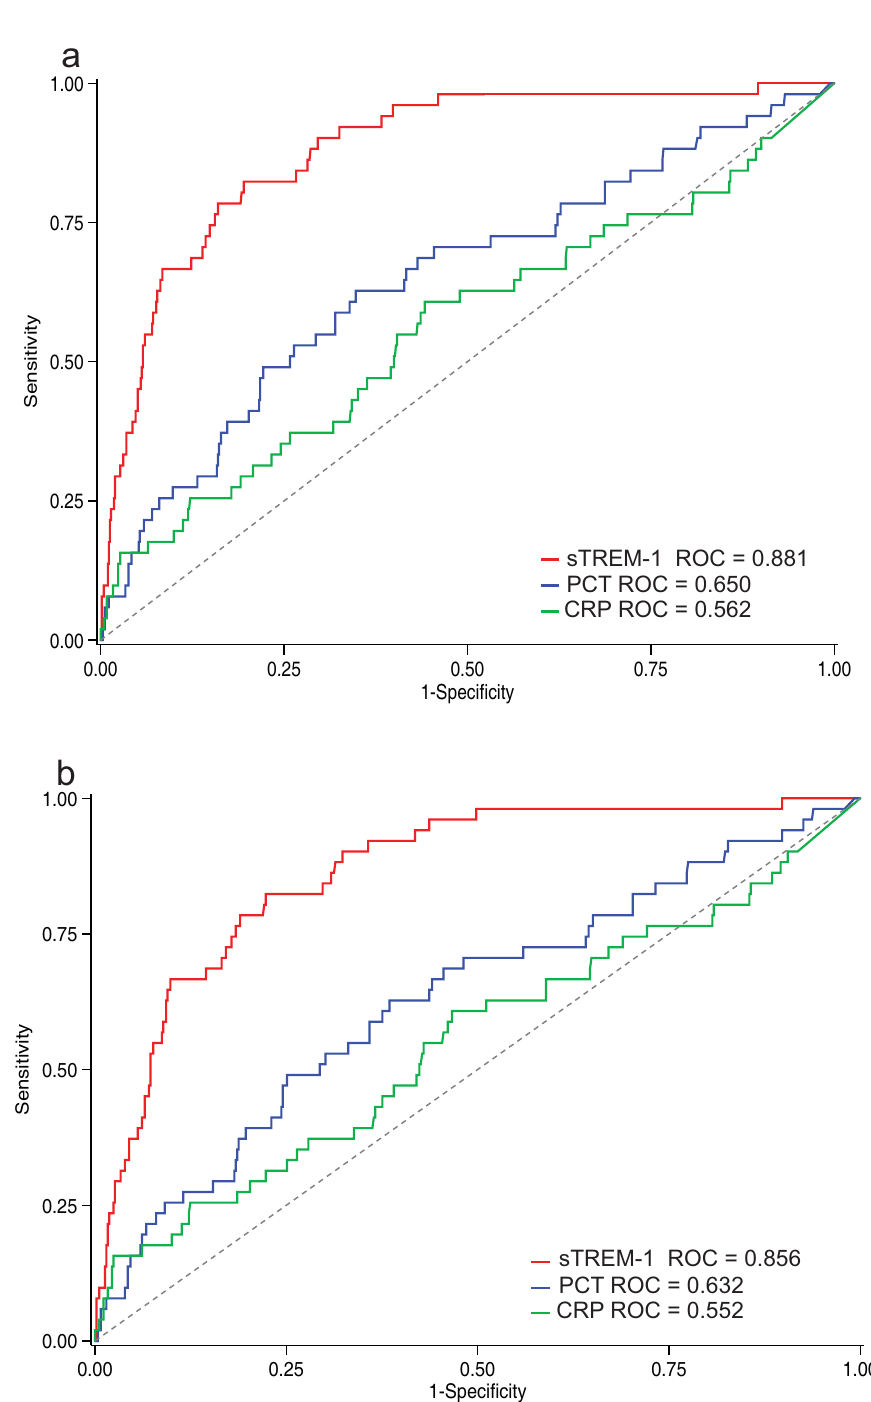
Fig 3. ROCs for predicting 48-hour in-hospital mortality using sTREM-1 versus nonspecific markers of inflammation. (a) sTREM-1 (AUROC 0.881, 95% CI 0.835–0.927) compared with PCT (AUROC 0.650, 95% CI 0.566–0.734, P < 0.001) and CRP (AUROC 0.562, 95% CI 0.472–0.653, P < 0.001) in cases of IMCI pneumonia and (b) sTREM-1 (AUROC 0.856, 95% CI 0.817–0.914) compared with PCT (AUROC 0.632, 95% CI 0.547–0.716, P < 0.001) and CRP (AUROC 0.552, 95% CI 0.461–0.644, P < 0.001) in cases of severe pneumonia. AUROC, area under receiver operating characteristic curve; CRP, c-reactive protein; ROC, receiver operating characteristic curve; PCT, procalcitonin; sTREM-1, soluble triggering receptor expressed on myeloid cells-1.